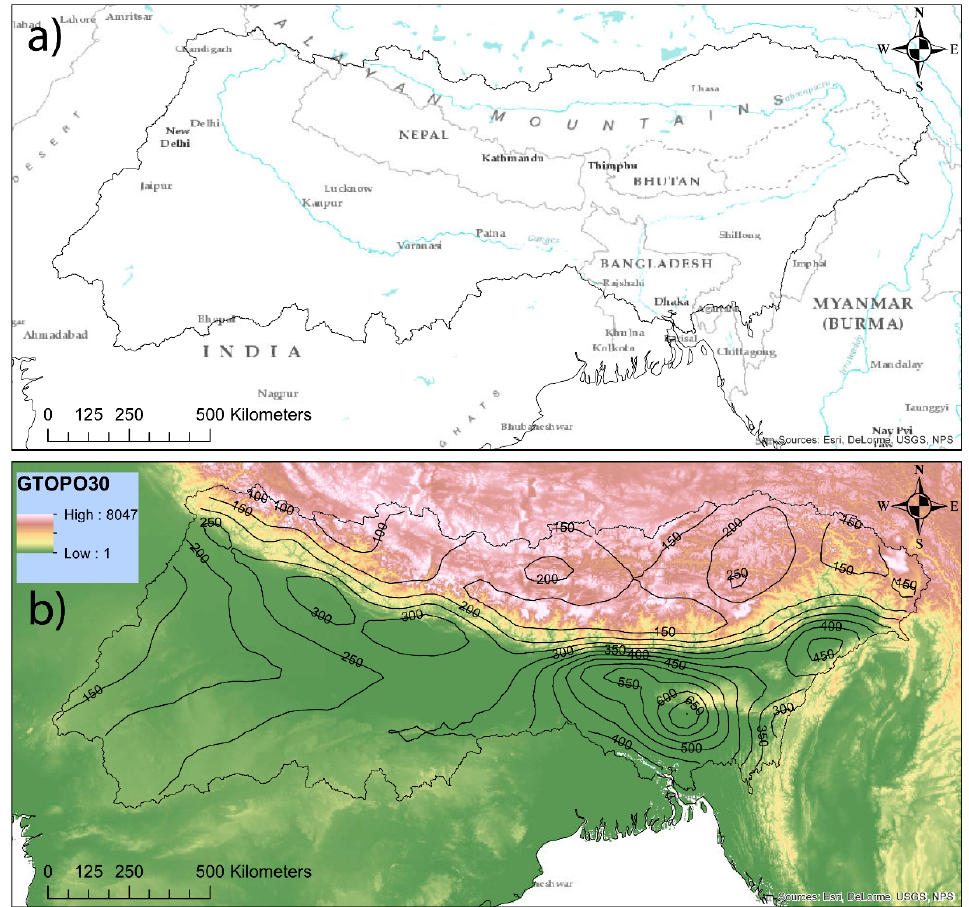
Figure 1. Ganges–Brahmaputra–Meghna (GBM) study area with ( a ) major rivers and political boundaries and ( b ) elevation in meters (colors) and June-July-August-September (JJAS) 1983 to 2015 precipitation climatology in mm mo − 1 (contours).